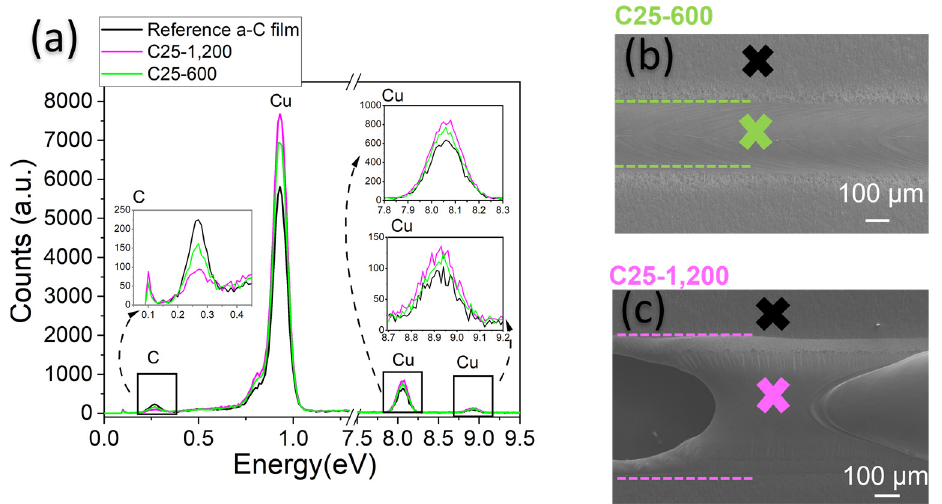
Figure 7. ( a ) Representative EDS of the 25 nm a-C ultra-thin film deposited over a copper foil and the fusion at ( b ) 600 W and ( c ) 1200 W. The color of the crosses in panels ( b , c ) indicates the corresponding place of the analysis shown in the spectrum ( a ).